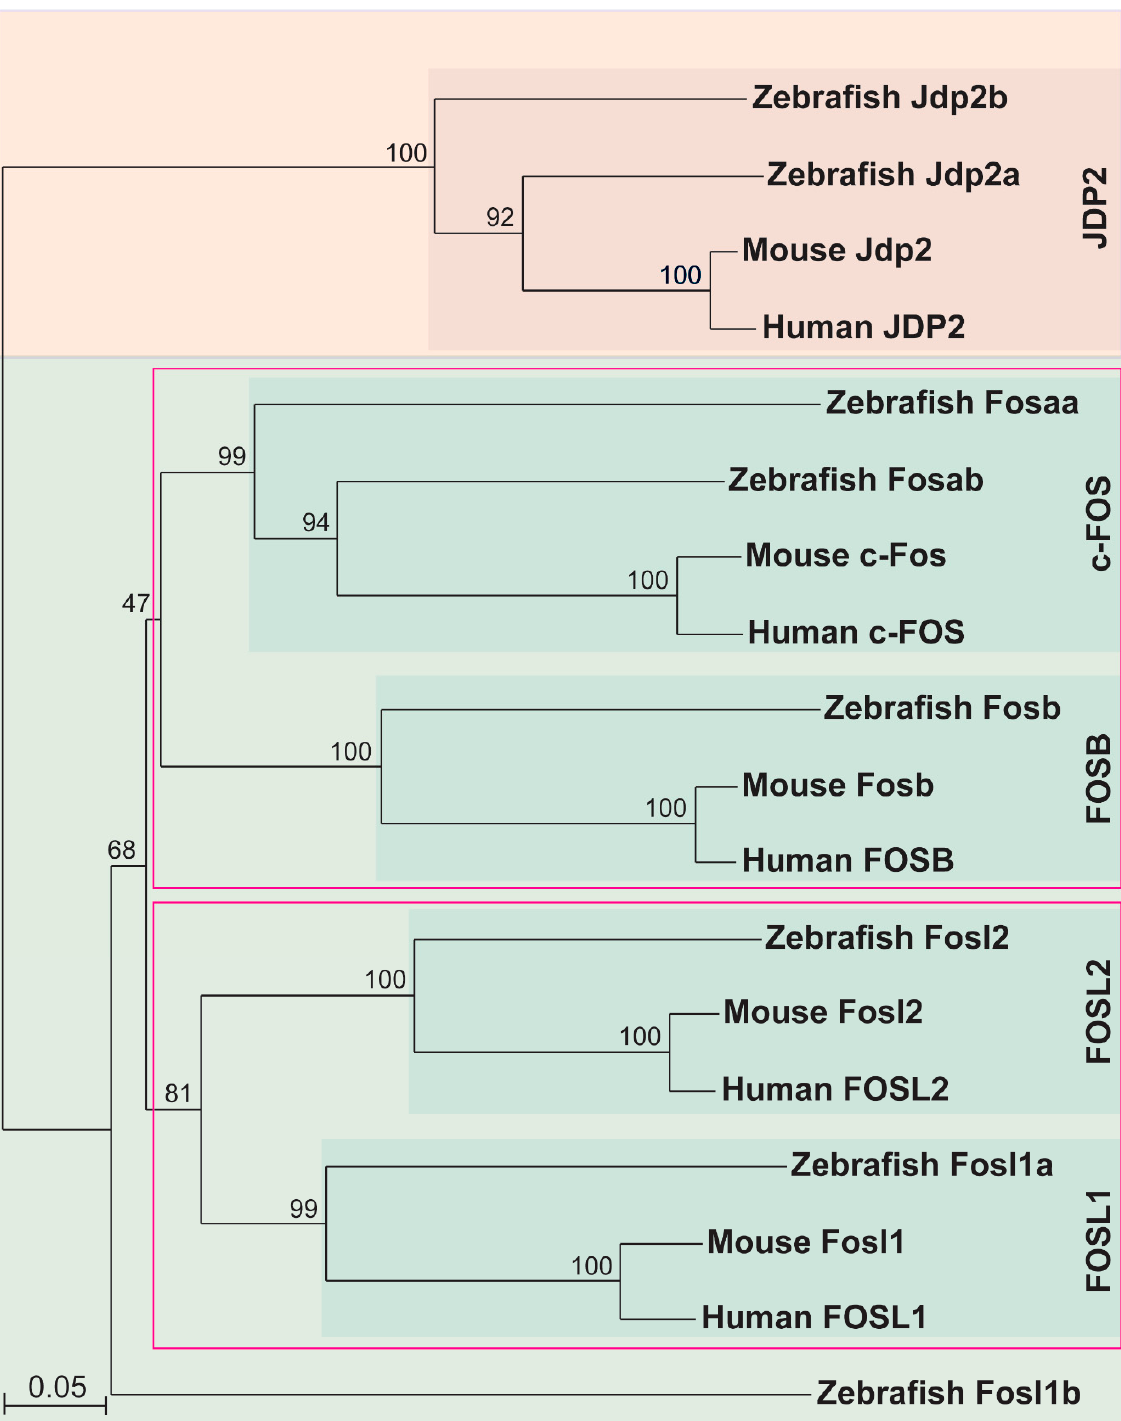
Figure 2. Phylogeny of mammalian and zebrafish FOS proteins. Phylogenetic analysis of human, mouse, and zebrafish FOS proteins were performed using the neighbour-joining algorithm and visualised with TreeView, with bootstrap values represented as a percentage of 1000 replicates and the relative evolutionary distance represented at the bottom left corner. JDP2 proteins were used as a closely related outgroup. Clades of related proteins are indicated within pink coloured boxes.